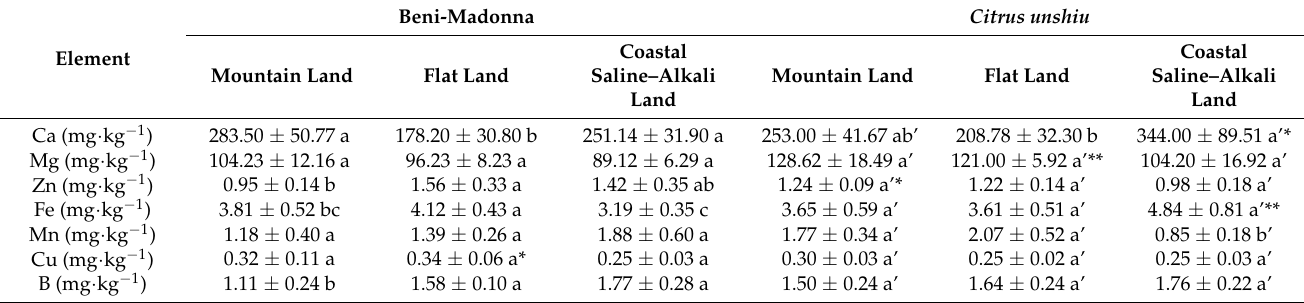
Table 2. The nutrient contents of the citrus hybrid Beni-Madonna and Citrus unshiu in Xiangshan County. The significant differences at p < 0.05 was indicated by small letters. The significant differences between the two varieties were indicated by asterisks (* p < 0.05; ** p < 0.04). a, a’ was used for the significant difference among landforms of Beni-Madonna and Citrus unshiu ,